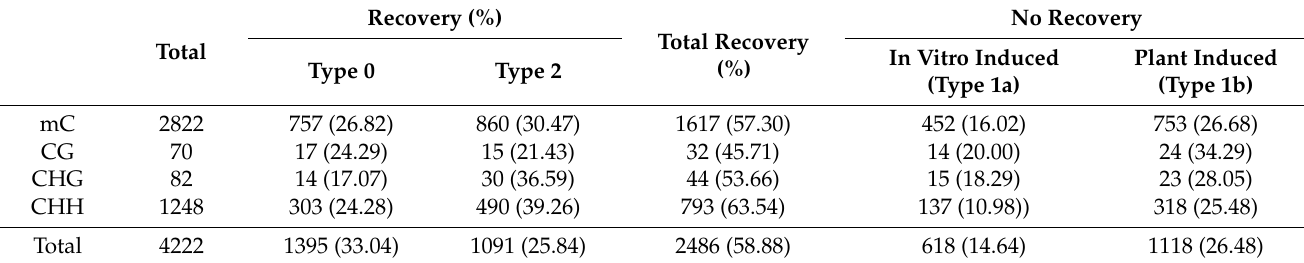
Table 2. Number of differentially methylated regions (DMRs) between T1, T8 and T8P samples. DRMs (i.e., regions presenting significantly different methylation levels between one sample and the other two samples (FDR < 0.01)) were determined using a three-sample Kruskal-Wallis test. Methylation levels were analysed by sliding window analysis using swDMR. DMRs were determined for all cytosines and for three methylation contexts. DMRs were grouped according to their changing patterns into recovery (T1 = T8P) and non-recovery (T1< > T8P). Two subgroups were found for recovery (T1 = T8P < T8 (Type 0) and T1 = T8P > T8 (Type 2)) and non-recovery (T1 > T8 = T8P (Type 1a) and T1 = T8 < T8P (Type 1b)). Percentage of the total DMRs for each pattern type/sequence context is shown in